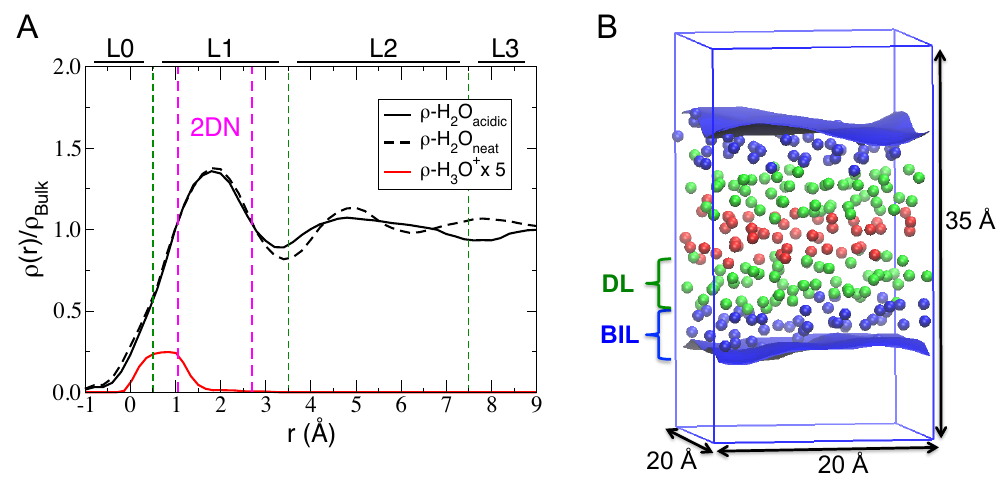
Figure 1. ( A ) Time averaged water density profiles ( ρ ( r ) ) normalized with respect to bulk water density ( ρ Bulk ), as a function of the distance (r) from the instantaneous water surface. The r = 0 value corresponds to the instantaneous surface, r is positive when going into the liquid phase, and negative into the vapour phase. The density profile is obtained by averaging over the four simulations of the air-water interface including one hydronium at the interface (black solid line), it is compared to the one obtained at the neat air-water interface, taken from ref. [22]. The L0–L3 water layers are shown, as well as the boundaries of the 2DN. The density profile of the hydronium is also reported and enhanced by a factor of five to better appreciate its average position between L0 ald L1 layers, just above the 2DN. ( B ) Snapshot of the simulation box of the acidic air-water interface, highlighting the instantaneous interface in blue-shade (top & bottom), the water in the BIL (Binding Interfacial Layer) in blue, the water in the DL (Diffuse Layer) in green, and the water in centrosymmetric bulk in red. Waters are represented by one sphere in a coarse-grain